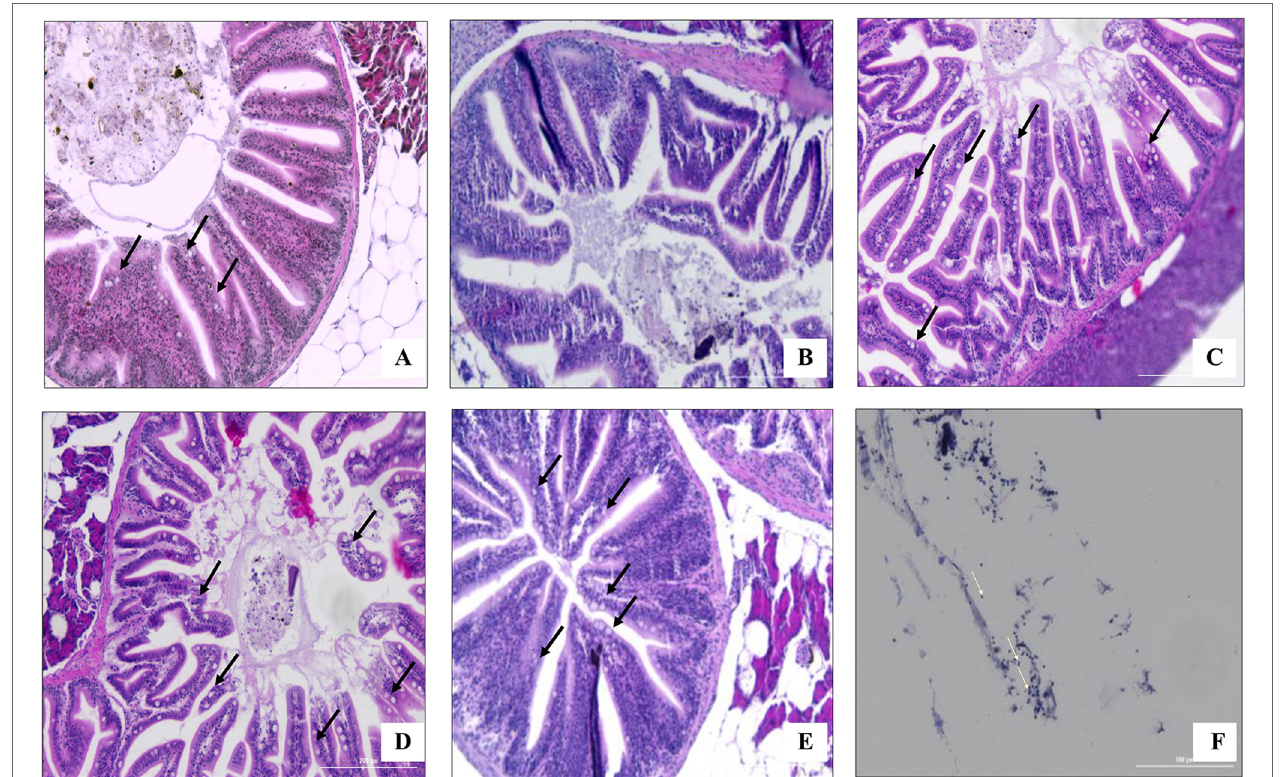
FIGURE 6 | Histological analysis of the goblet cells (black arrow) in the intestine of zebrafish challenged with S. parauberis. (A) non-infected group with control diet (B) infected group fed with control diet, (C) infected group fed with 5% SHC supplemented diet, (D) infected group fed with 1% L. plantarum supplemented diet, (E) infected group fed with 1% L. plantarum + 5% SHC supplemented diet and (F) bacterial cells in the intestinal lumen (white arrow). (SHC, S. horneri Celluclast